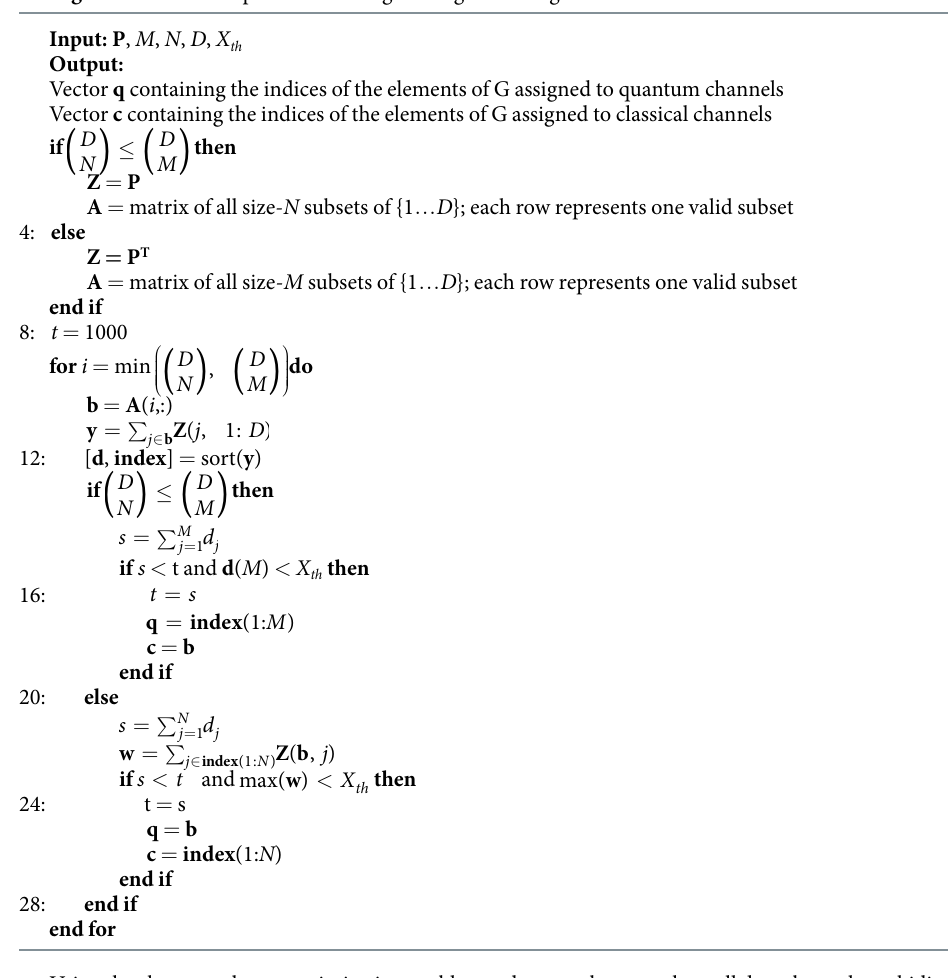
Algorithm 1. Near-Optimal Wavelength Assignment